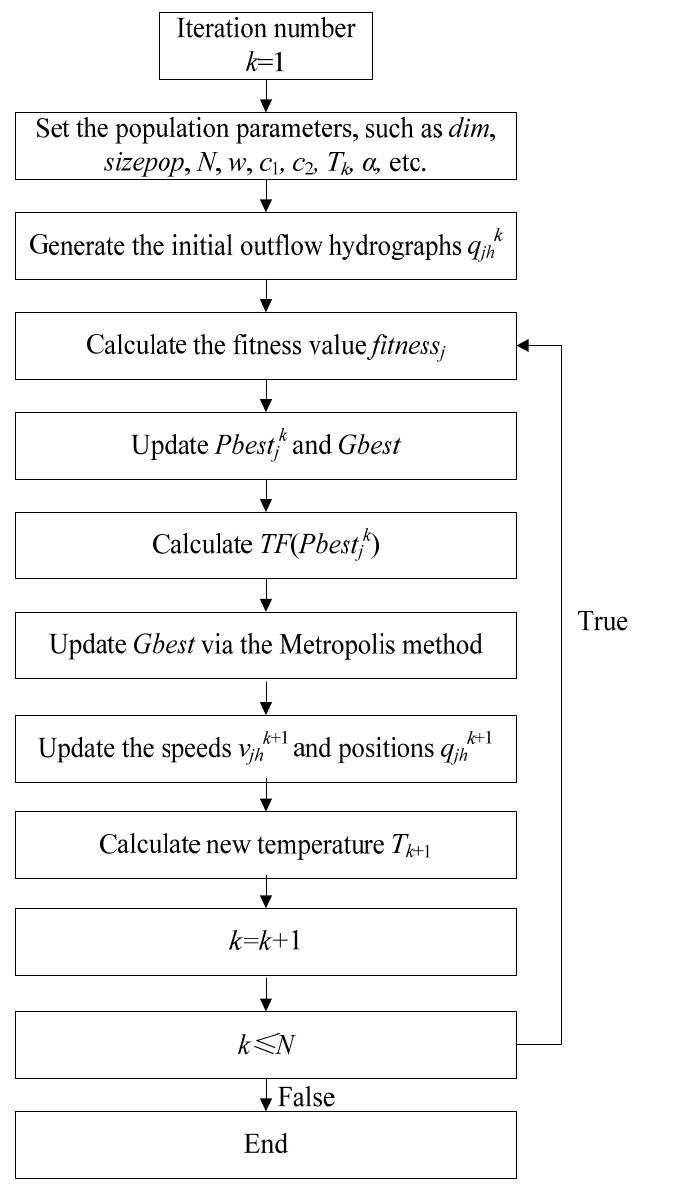
Figure 1. The flowchart of the procedure for determining optimal operation using the SAPSO algo- rithm .